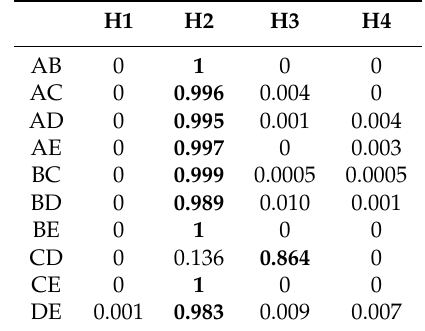
Table 6. Posterior probabilities for H1–H4, highest row values boldfaced.